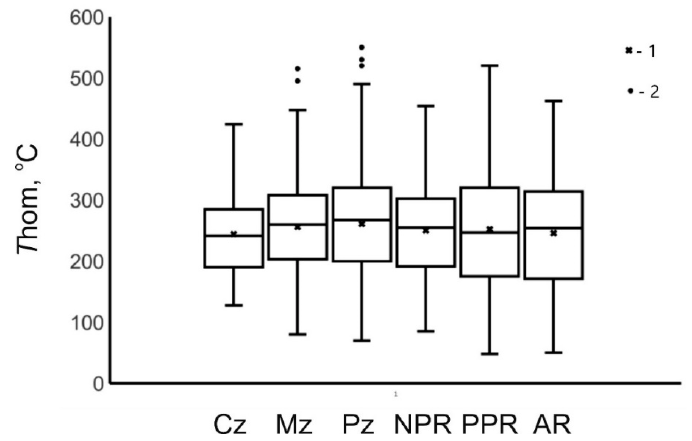
Figure 6. Boxplot diagrams for the temperatures of the mineralizing fluids of orogenic gold deposits